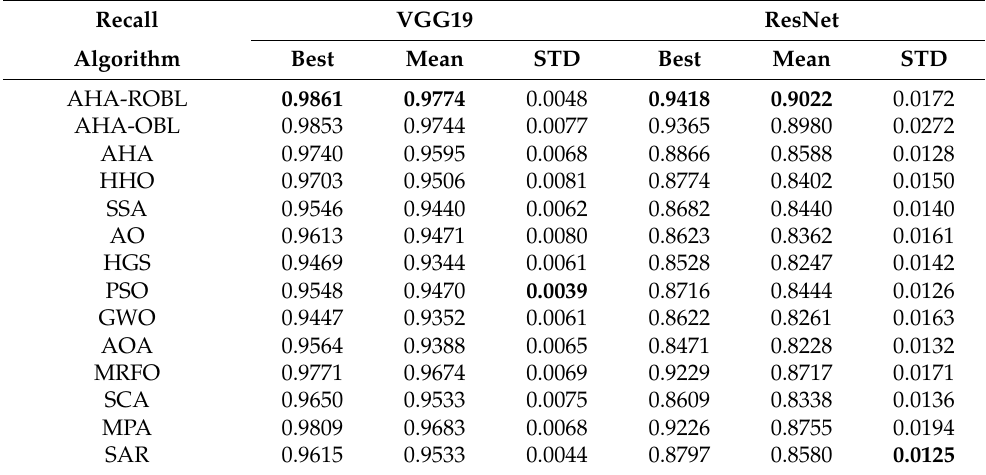
Table 4. Comparison of the performance of deep feature models of the AHA-ROBL with other recent optimizers versus avg. recall.